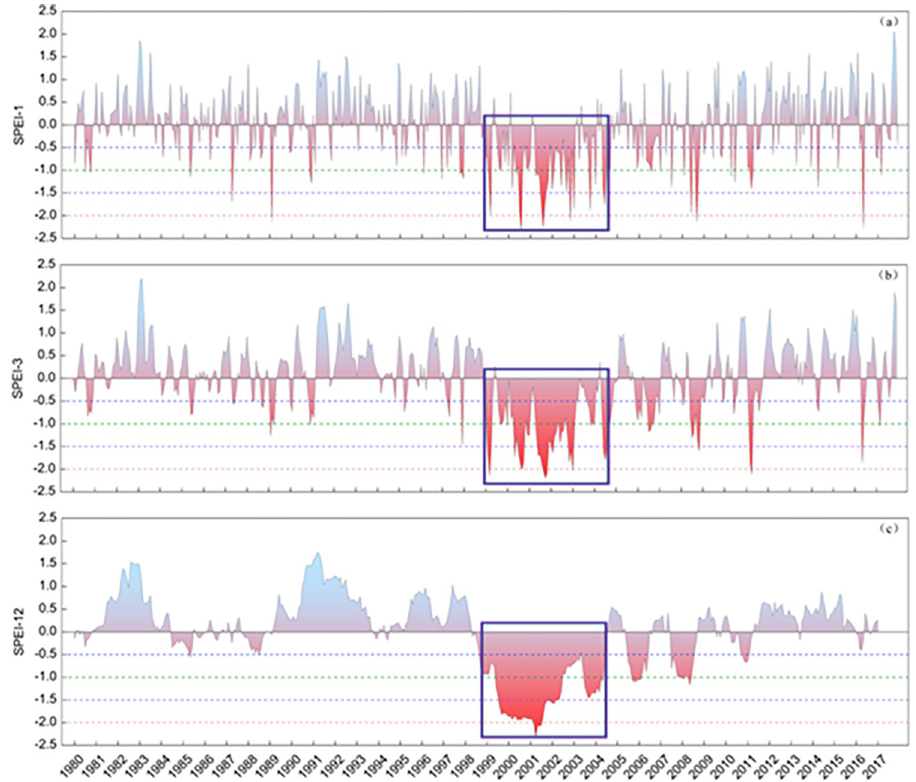
Fig 4. Temporal distribution of the mean SPEI at sub-catchment scale in Afghanistan for each year from 1980 to 2017: (a) monthly (SPEI-1), (b) seasonal (SPEI-3) and (c) annual (SPEI-12). The prolonged drought period from 1999 to 2004 is highlighted. Blue dotted line = Mild Drought, green dotted line = Moderate Drought, purple dotted line = Severe Drought; and red dotted line = Extreme Drought.